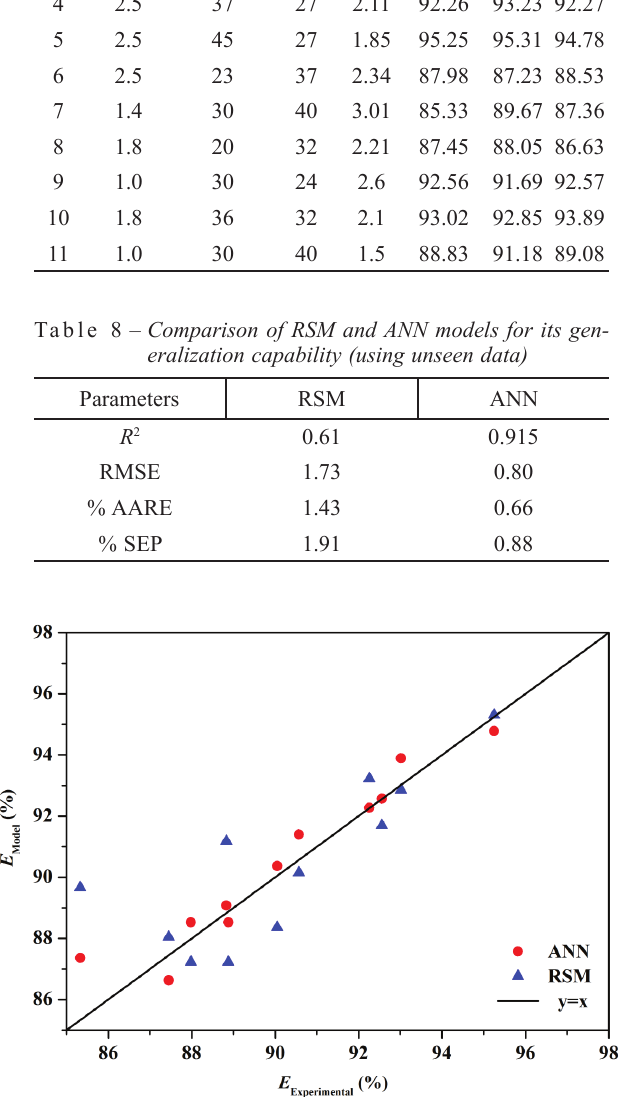
Fig. 8 – Comparison of RSM and ANN model predictions for the unseen data (data not used in the model development)